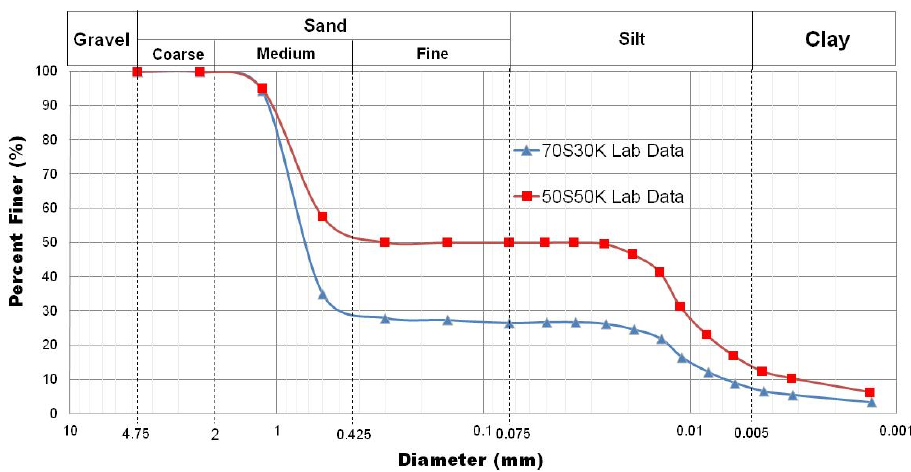
Figure 3. Grain size distribution curve.